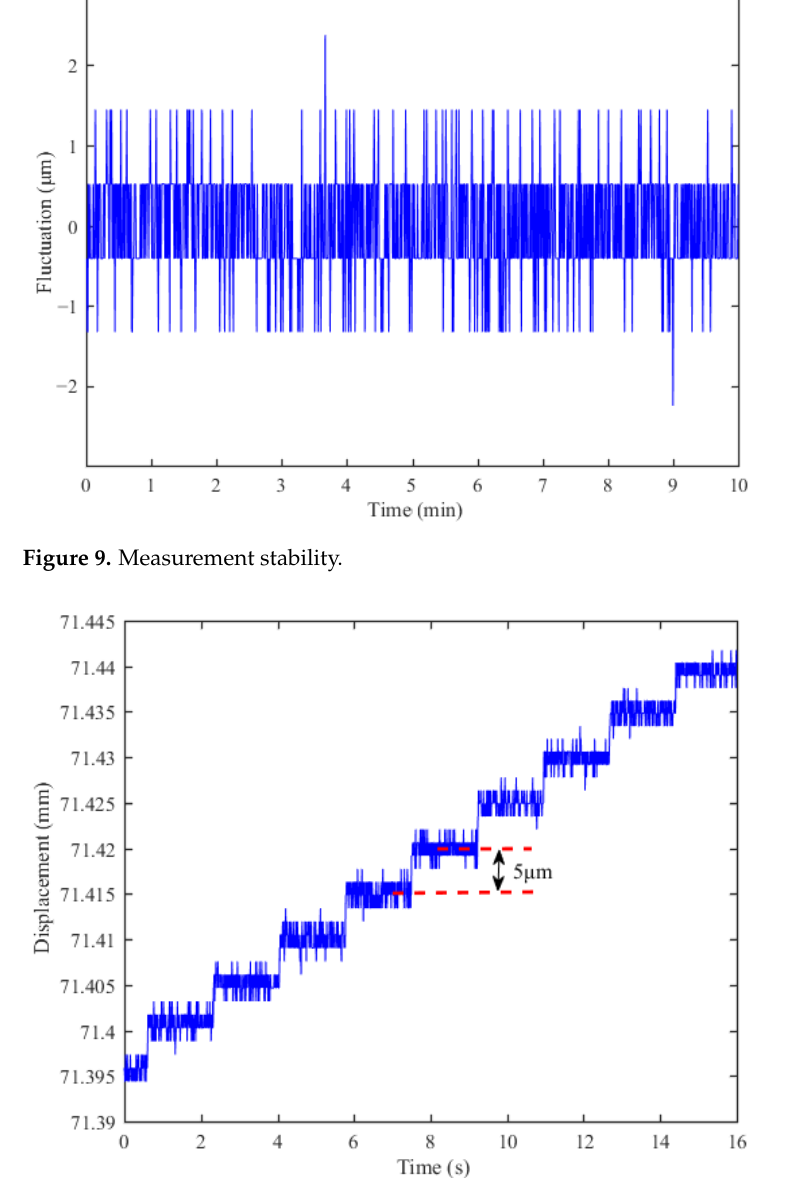
Figure 10. Resolution test